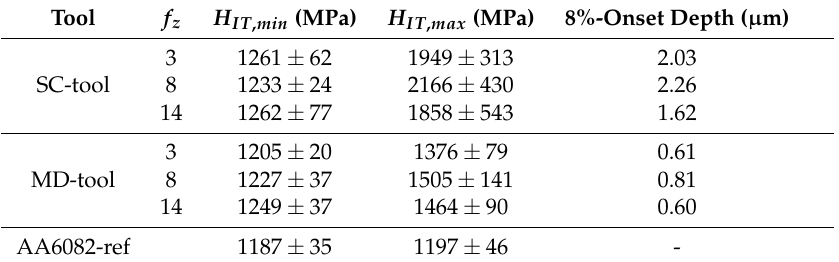
Table 6. Summary of the minimum (at max. depth) and maximum (at min. depth) hardness values and the onset depth of the strain-hardening for all machined samples. Average onset values are presented in the